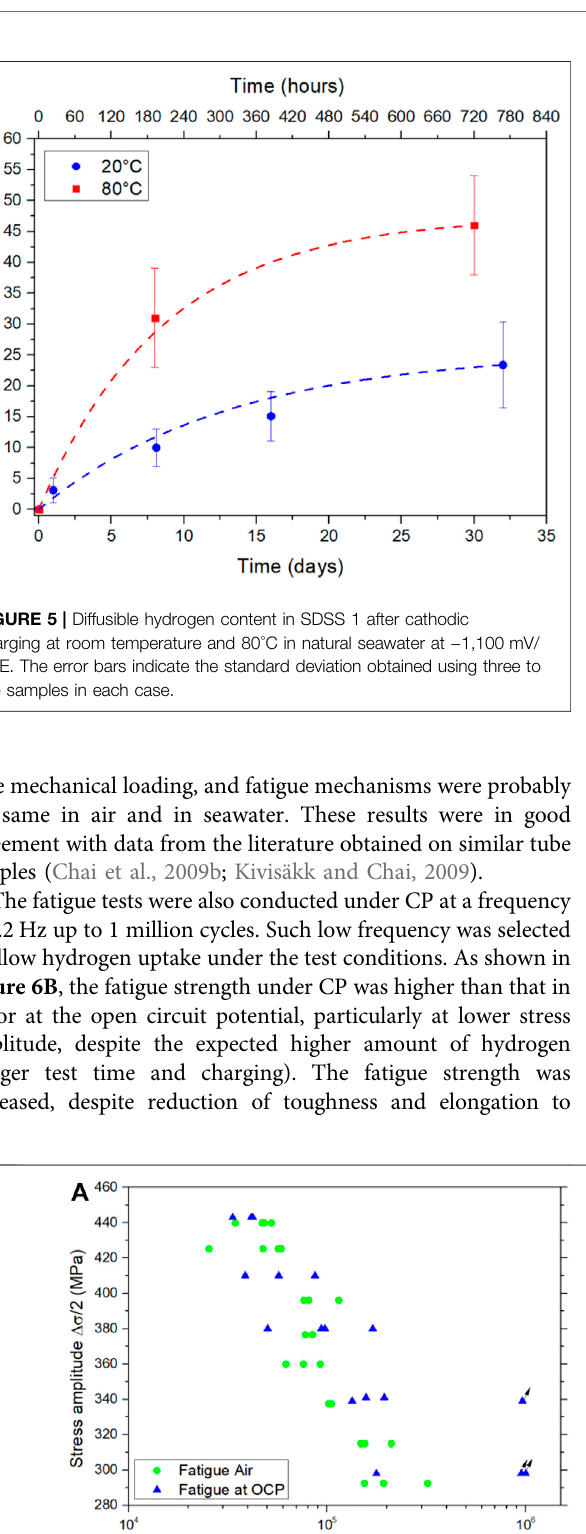
Frontiers in Materials |